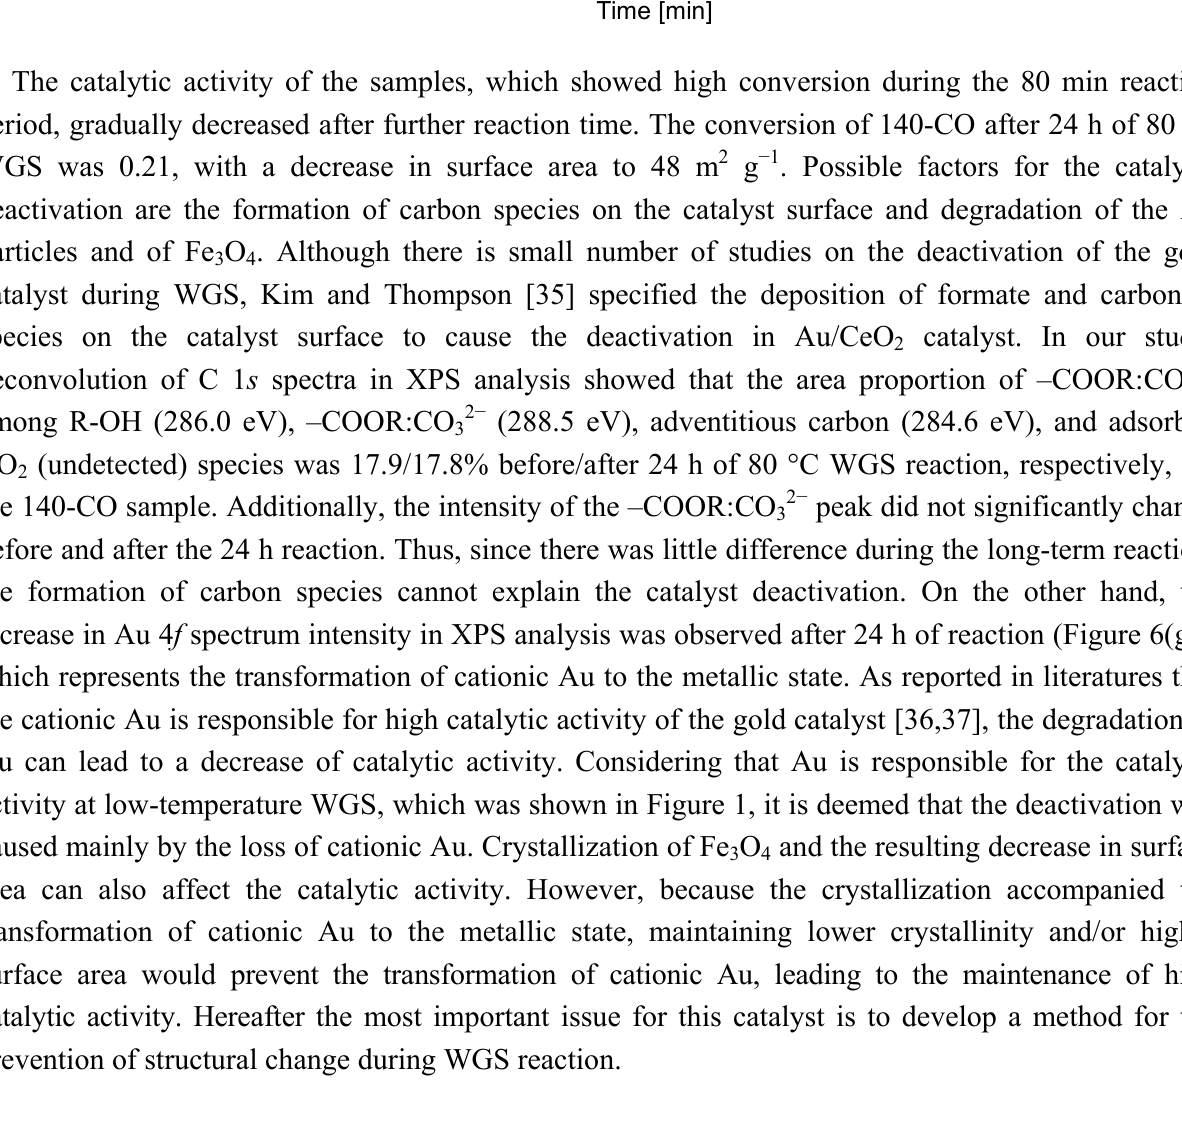
Figure 8. Catalytic performance of non-reduced Au/Fe for WGS at 80 °C (0.3 g of catalyst, CO/H